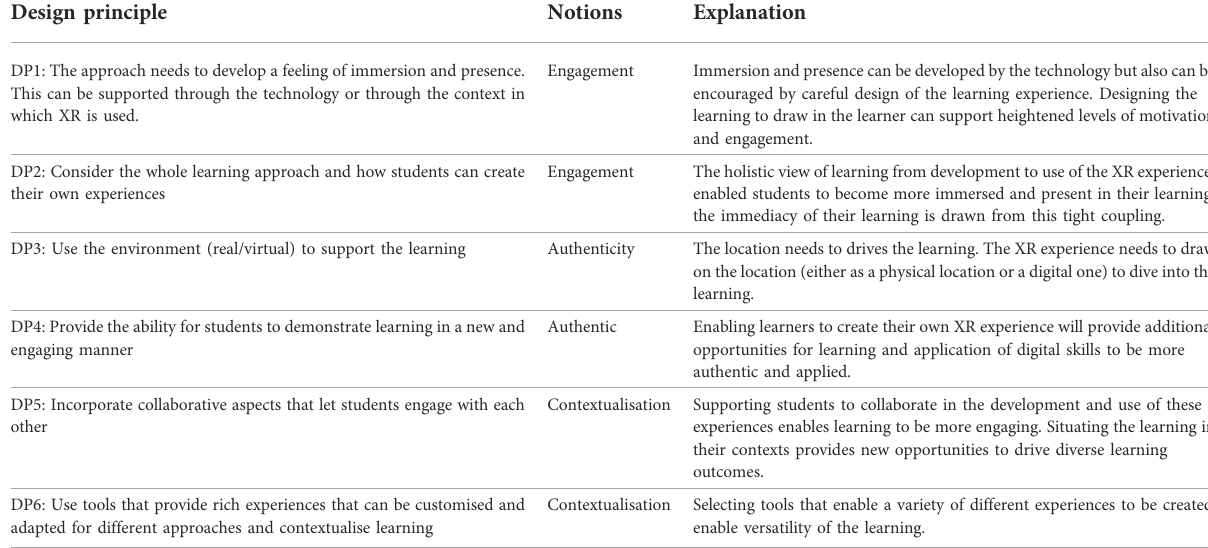
TABLE 2 Design principles are drawn from the above-discussed